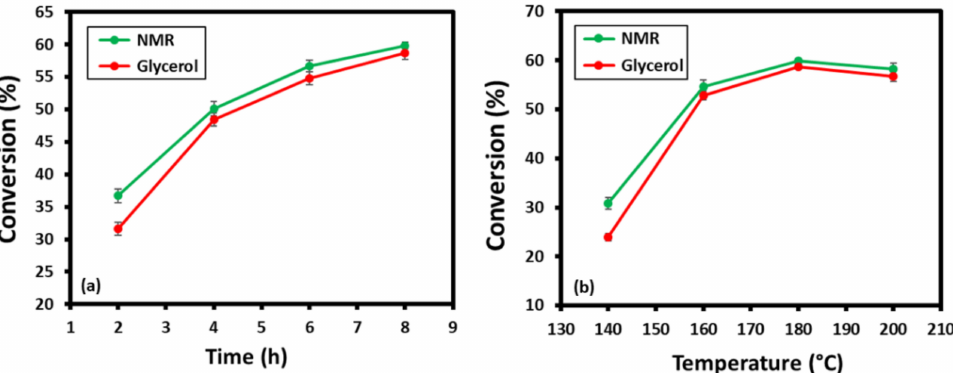
Figure 8. Transesterification of UVO over MOF-801, ( a ) at a different time interval. (Green line conversion based on NMR and red line conversion based on the yield of glycerol) and ( b ) at different